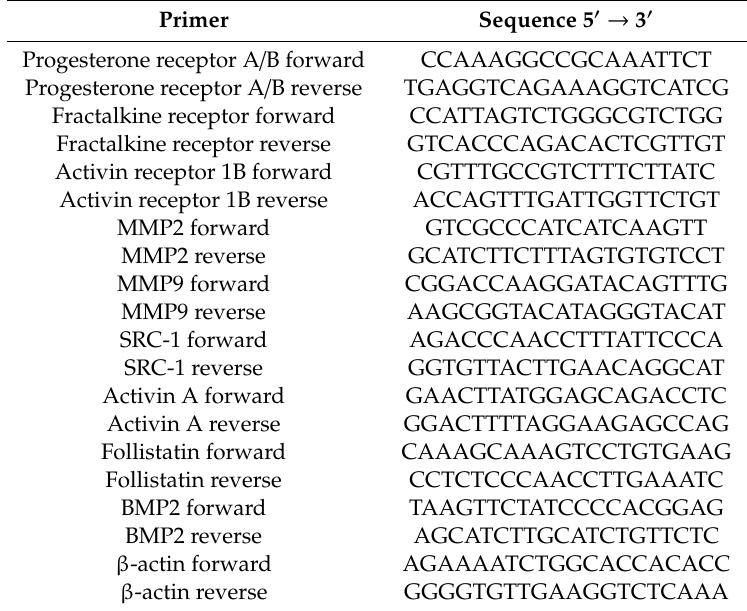
Table 1. Real-time PCR gene primer